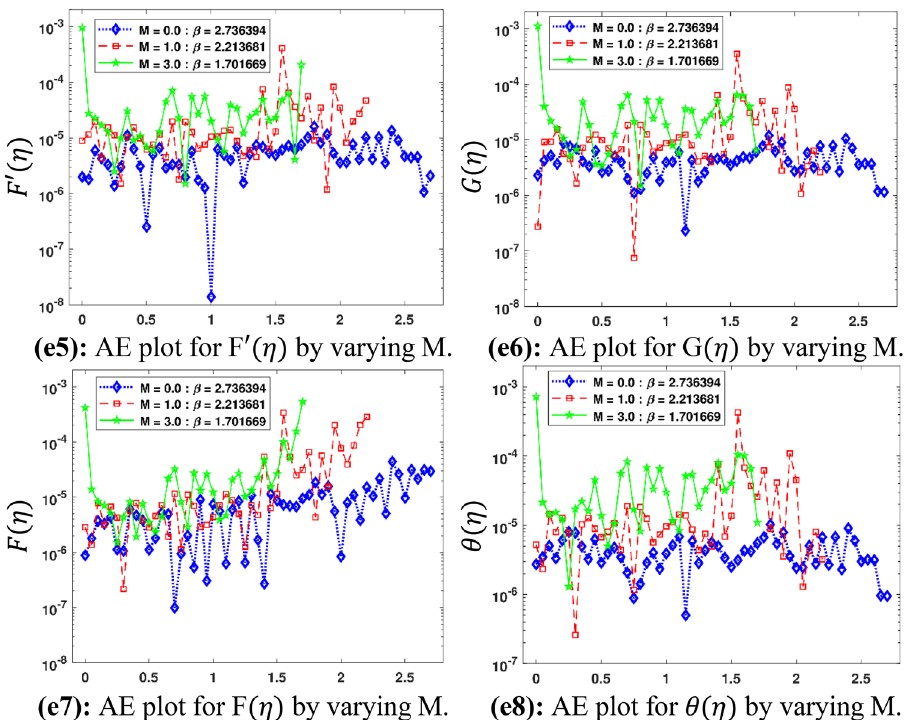
Figure 13. AE plots for outputs by proposed scheme and reference data.